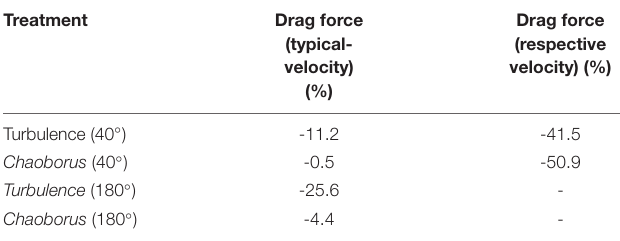
TABLE 3 | Drag force alteration (%) of the turbulence and Chaoborus -exposed morph of D. cucullata in comparison to the typical morph at typical and respective velocities.